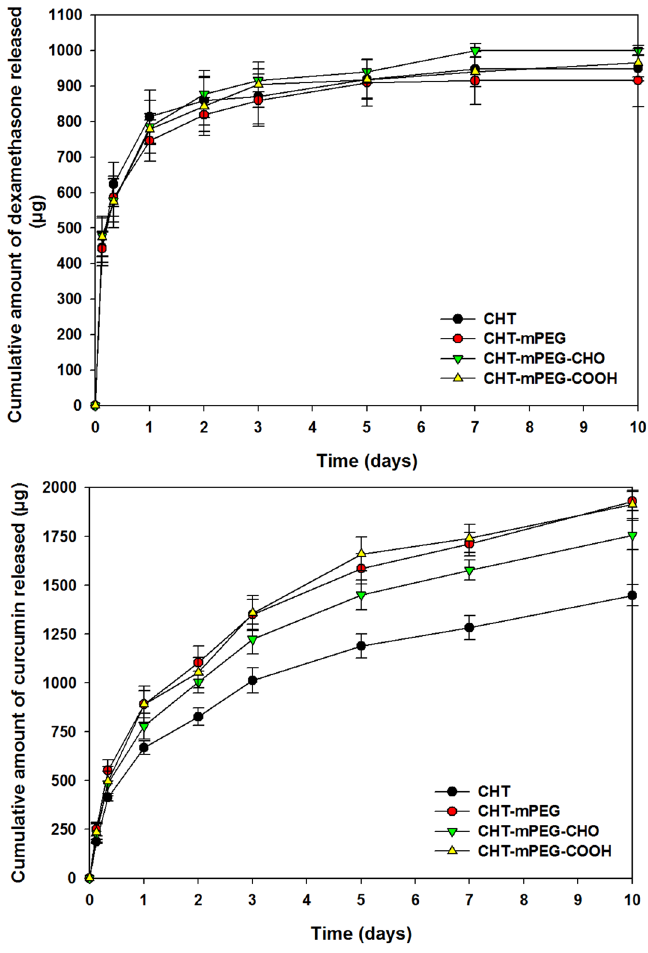
Figure 10. Drug release profiles of various cryosponge formulations over 10 days (data represent mean ± std. dev. from 3 independent